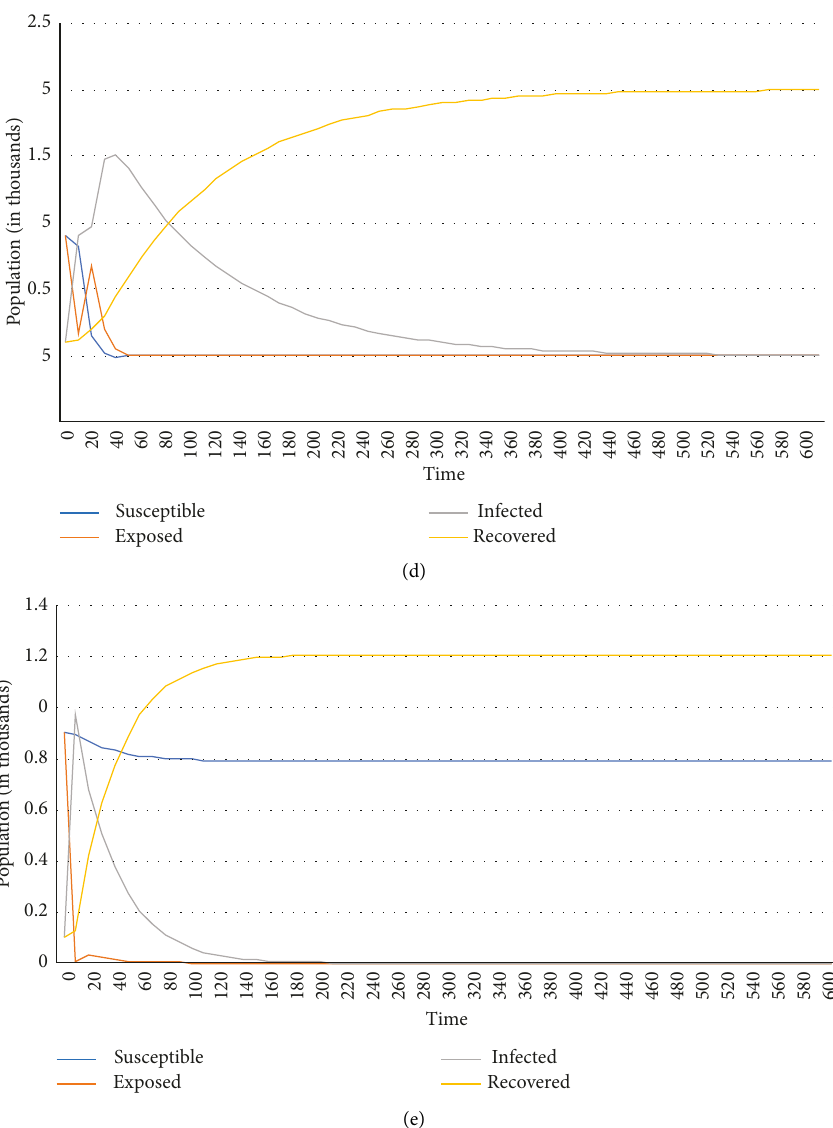
Figure 6: SEIR model with (a) β � 0 . 0095, c � 0 . 004, and σ � 0 . 01; (b) β � 0 . 0095, c � 0 . 03, and σ � 0 . 1; (c) β � 0 . 01, c � 0 . 004, and σ � 0 . 0025; (d) β � 0 . 09, c � 0 . 01, and σ � 0 . 09; and (e) β � 0 . 00348, c � 0 . 03, and σ � 0 .